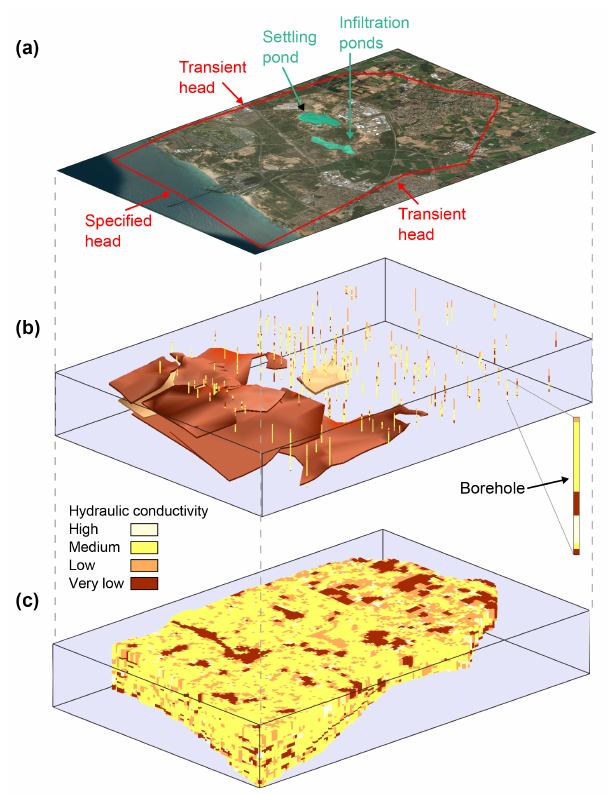
Figure 2. The model used in simulations of water flow and solute transport. (a) The modeled area and boundary conditions. (b) The major continuous marine clay lenses and the borehole log. (c) The combined deterministic and geostatistically generated material ar- ray representing the aquifer in the